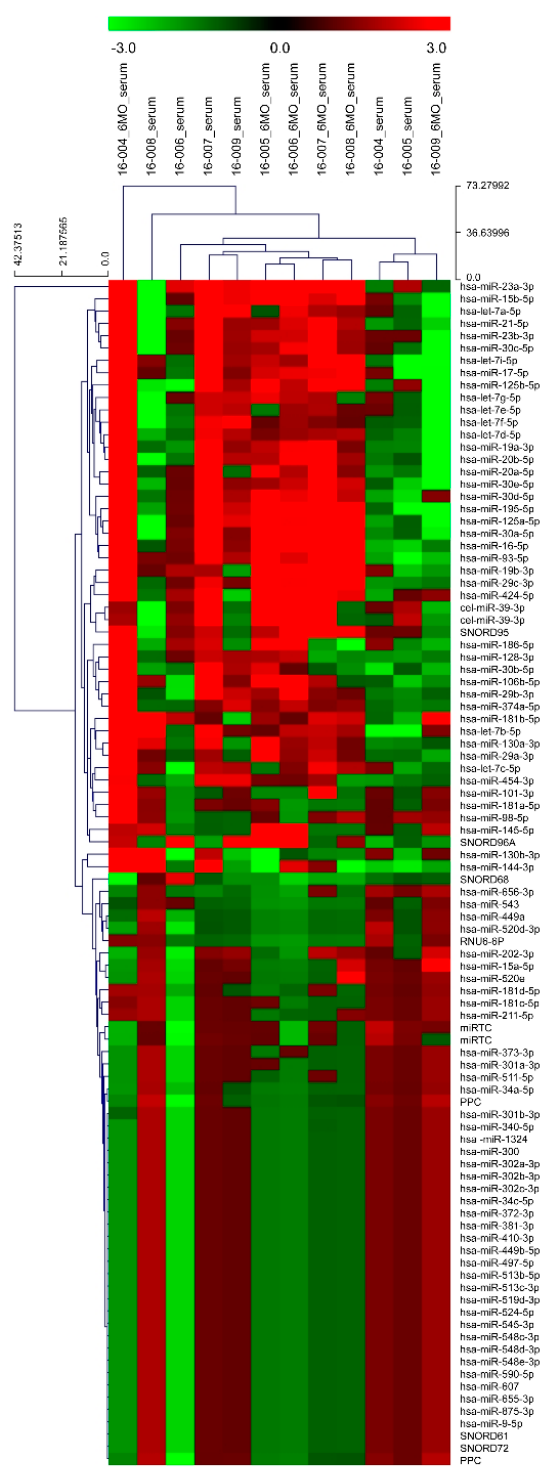
Figure 2. Heatmap showing the expression levels of 84 target miRNAs from miRNA PCR array screening performed for serum samples collected from six patients at preoperative and postoperative month-6 time points.